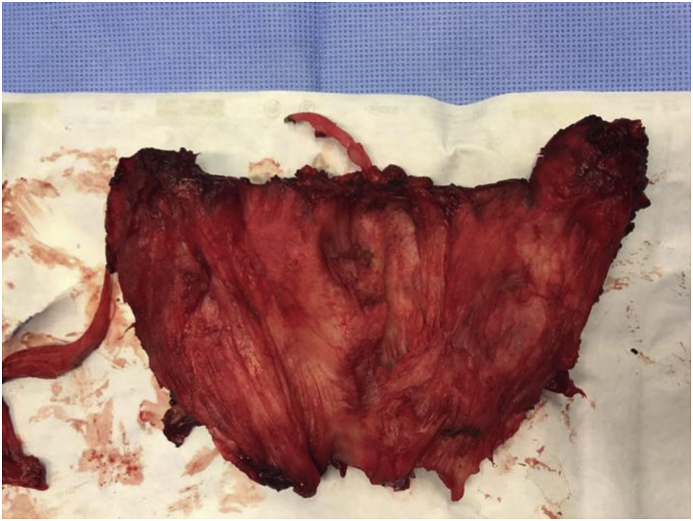
Surgical specimen.